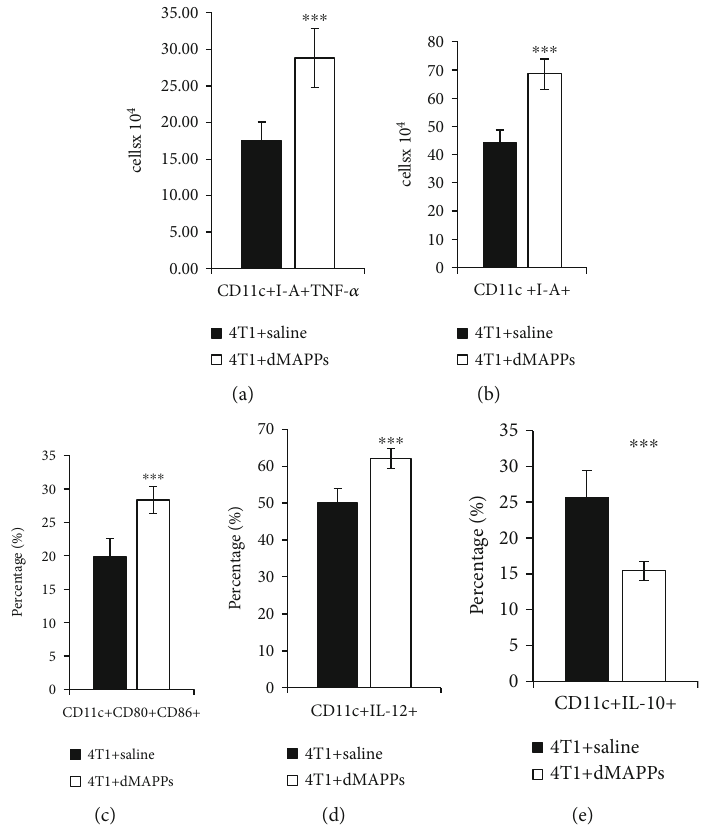
Figure 4: d-MAPPS improved antigen-presenting properties of tumor-in fi ltrated dendritic cells. Flow cytometry analysis and intracellular staining of tumor-in fi ltrated (a) I-A-expressing TNF- α -producing CD11c+, (b) I-A-expressing CD11c+, (c) CD80- and CD86-expressing CD11c+, (d) IL-12-producing CD11c+, and (e) IL-10-producing CD11c+ DCs in the tumors of 4T1+saline-treated (black bars) and 4T1+d-MAPPS-treated mice (white bars). Data are presented as mean + / − SEM ( n = 16 mice/group; ∗∗∗ p < 0 : 001